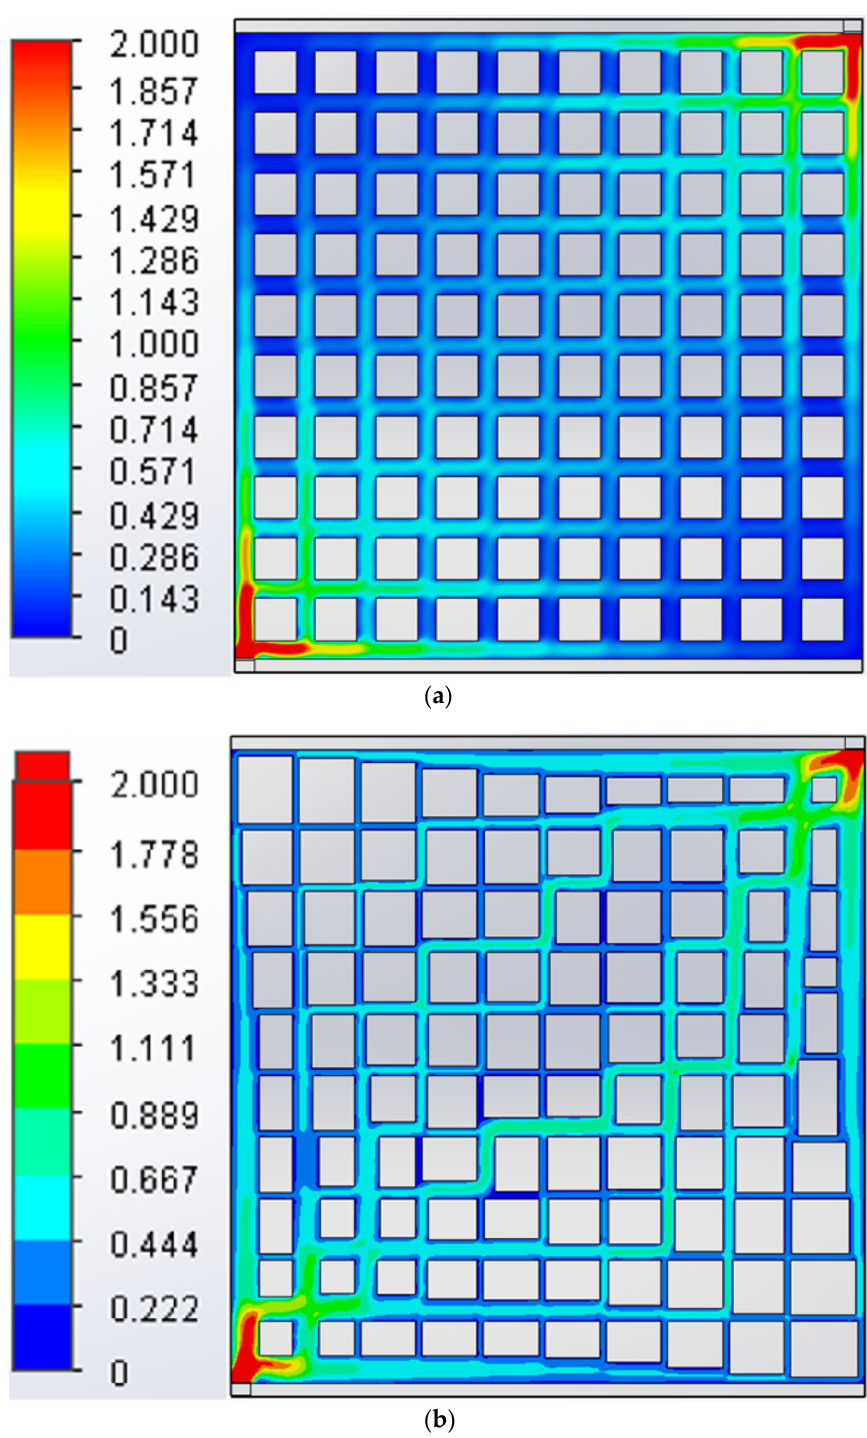
Figure 12. Velocity contour plot for 11 × 11 flow field in m/s (upper limit set to 2 m/s) ( a ) unopti- mized design; ( b ) MOGA design.